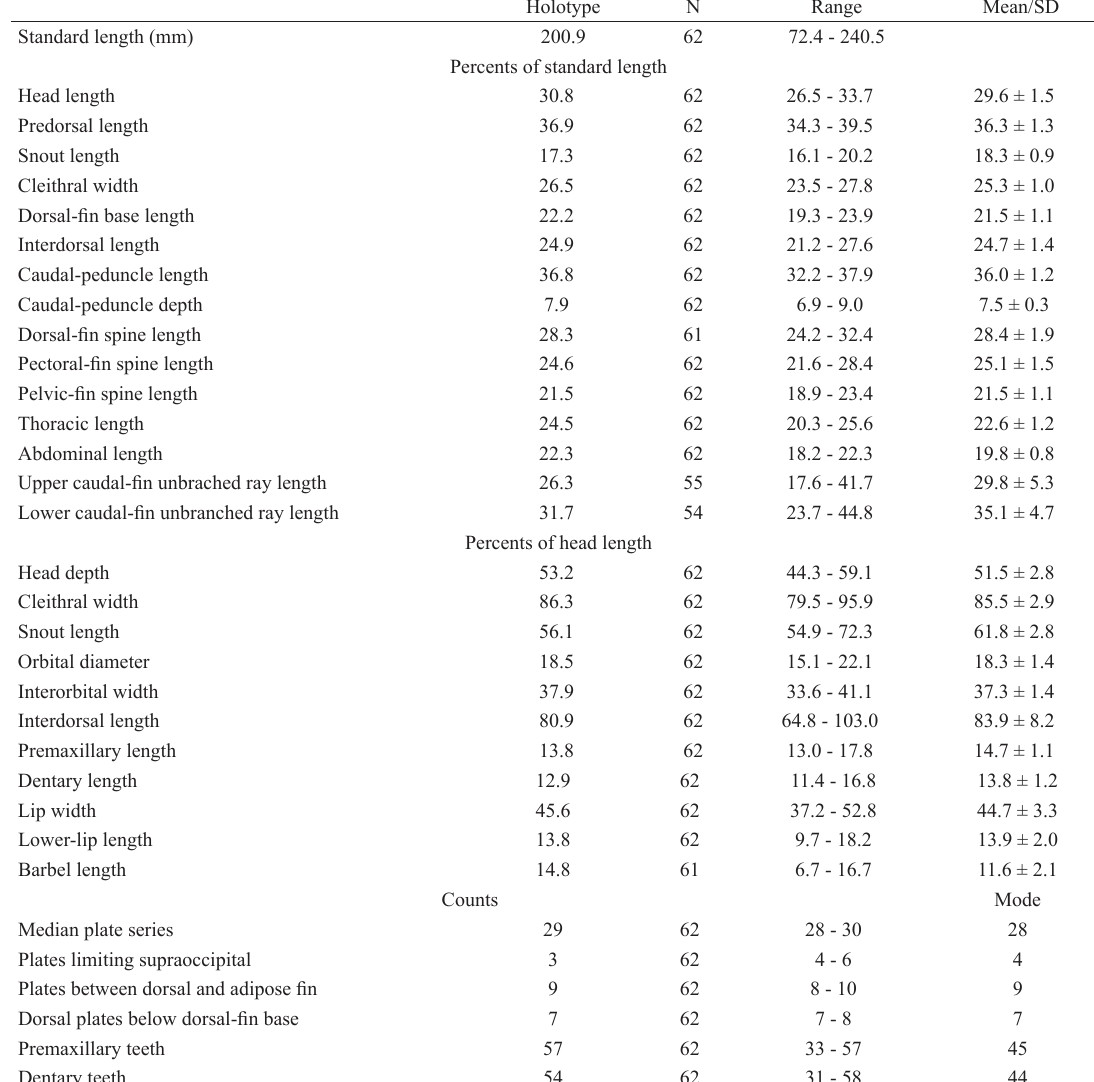
Tab. 1. Morphometric data and meristics of Aphanotorulus rubrocauda , new